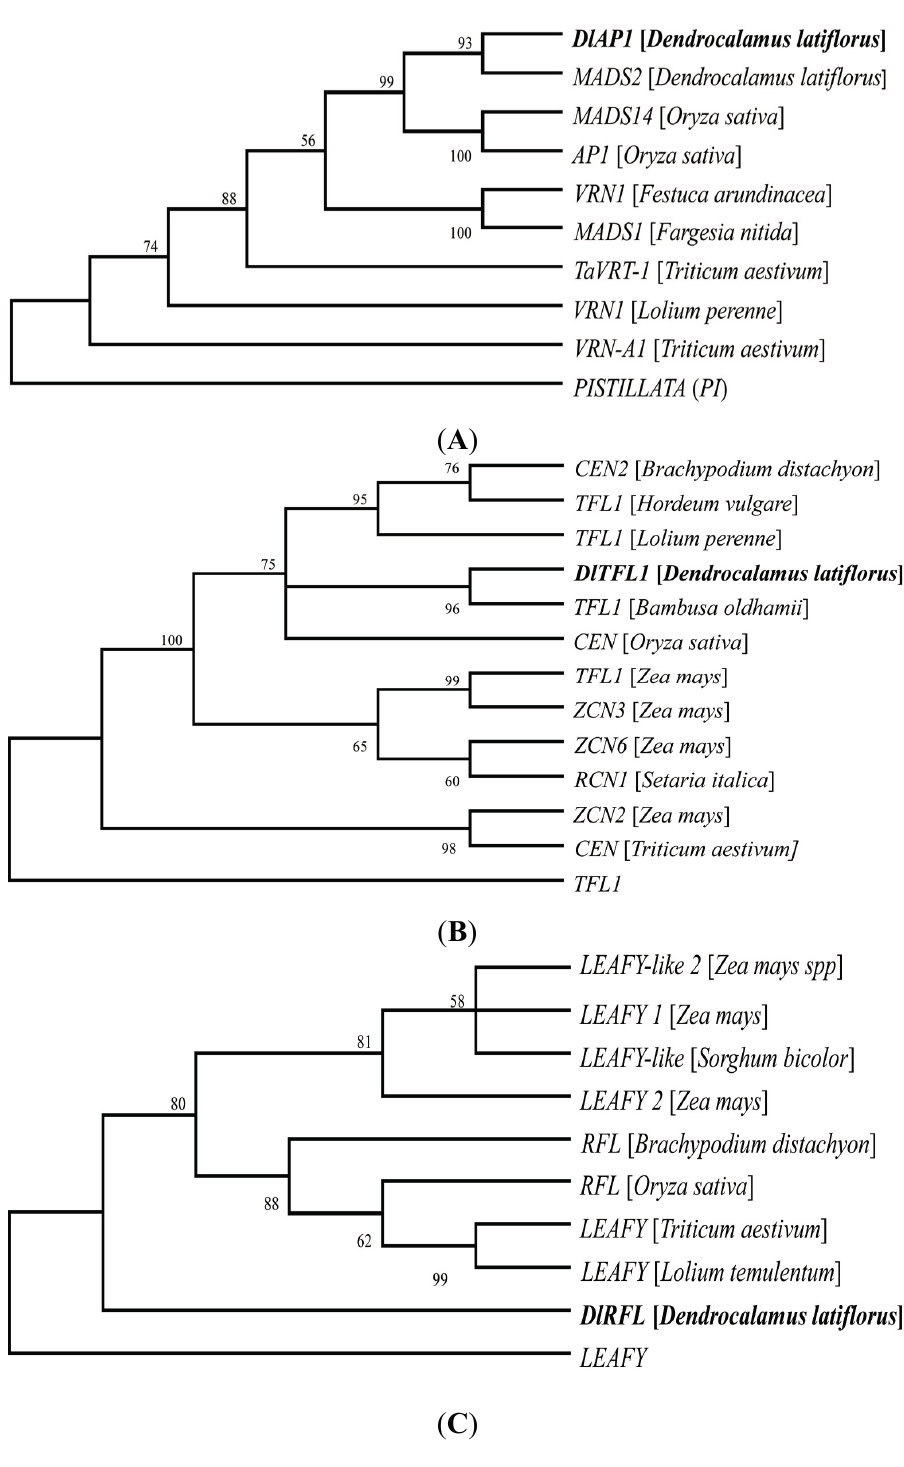
Figure 3. Unrooted phylogenetic trees of homologous genes in D. latiflorus and other grass species using NJ-method. ( A ) AP1 ; ( B ) TFL1 ; ( C ) RFL . Arabidopsis PISTILLATA ( PI ), TFL1 and LEAFY were used as out groups. Sequences isolated in this study are marked in bold. The statistics on the branches represented bootstrap